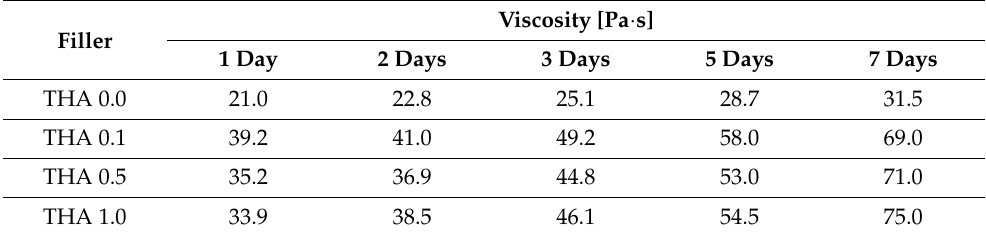
Table 4. Viscosity of silicon compositions containing 3 wt.% of modified